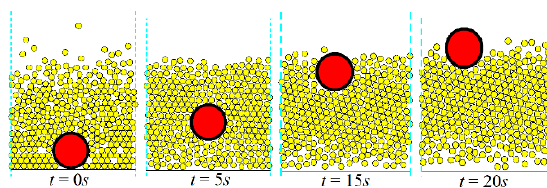
Fig. 4. The rising process of large particle （ k = 6